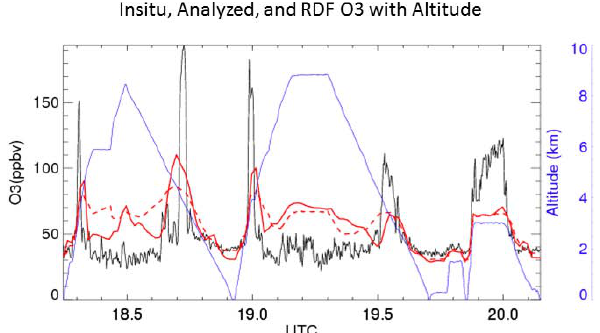
Fig. 10. Time series of in situ (black), RAQMS reverse domain filled (RDF) (solid red), and RAQMS-analyzed (dashed red) O 3 (ppbv) for AJAX flight on 5 June 2012. The first vertical profile is over the San Joaquin Valley and second vertical profile over the offshore location.